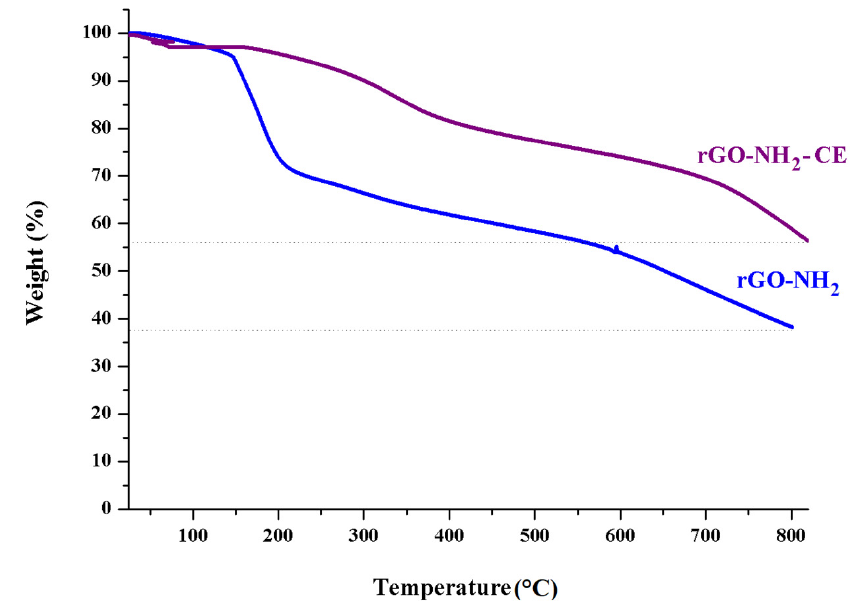
Figure 5. TGA curves of rGO-NH 2 before and after functionalization with CE. Table 3. T 10% , T max , R 800 and WL 100 values obtained from the thermogravimetric curves. Sample